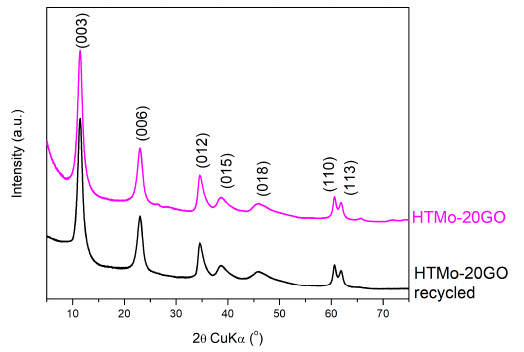
Figure 9. XRD patterns of HTMo-20GO before and after five reaction cycles.